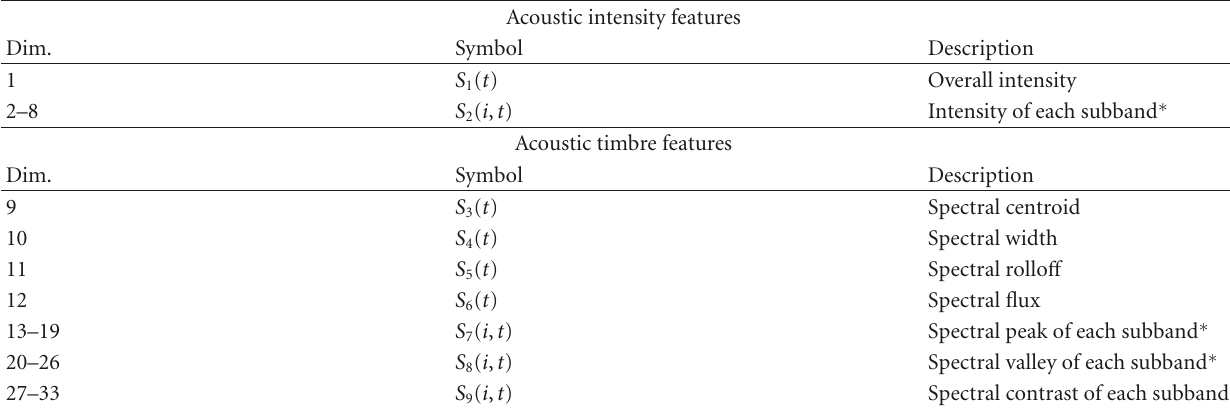
Table 1: Acoustic features representing musical